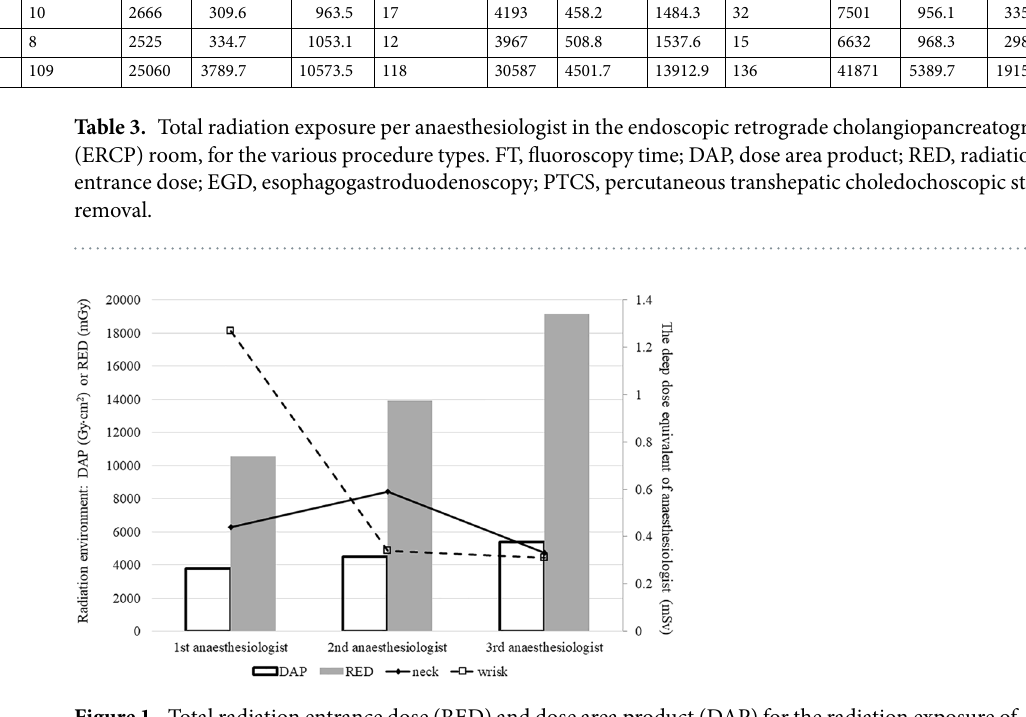
Figure 1. Total radiation entrance dose (RED) and dose area product (DAP) for the radiation exposure of each anaesthesiologist, and the effective radiation dose (neck and wrist) for each anaesthesiologist. The deep dose equivalents for the anaesthesiologists’ neck and wrist were not associated with the radiation environment variables such as total RED and